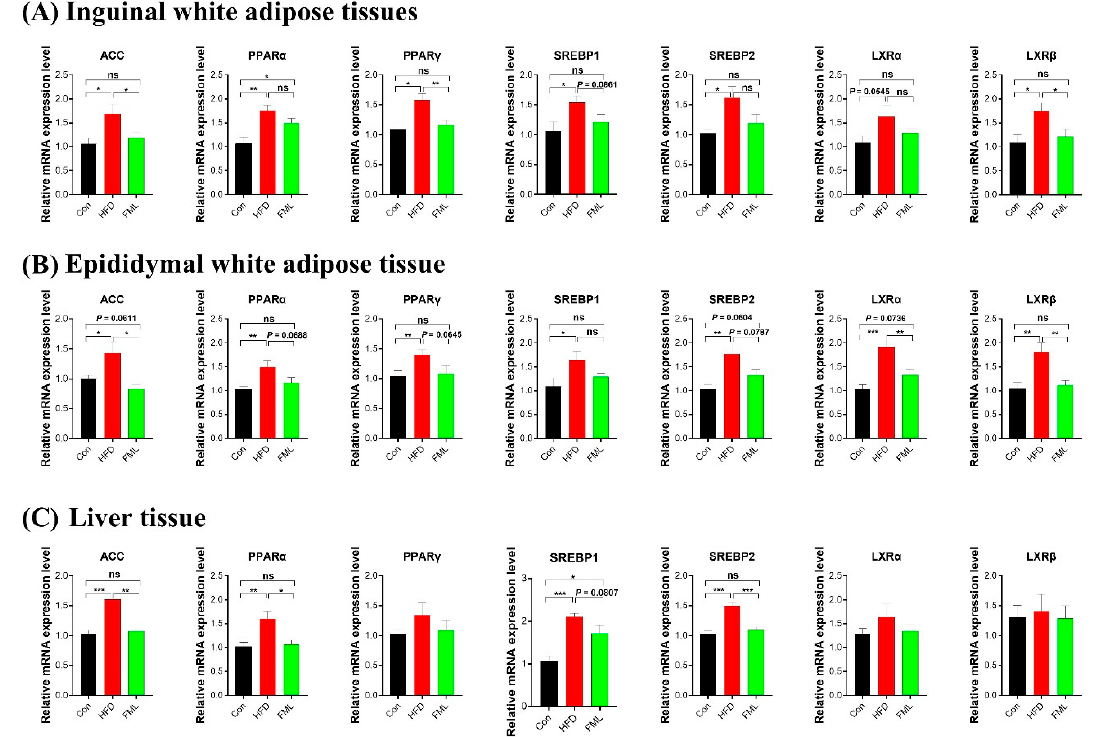
Figure 3. FML administration regulated the mRNA abundance of lipid metabolism-related genes in HFD-fed mice. ( A – C ) mRNA abundances of ACC, PPAR γ , SREBP1/2, and LXR α / β in iWAT, eWAT, and liver ( n = 8). Data are presented as mean ± SEM, differences were denoted as follows: * p < 0.05, ** p < 0.01, *** p < 0.001; ns p > 0.05.